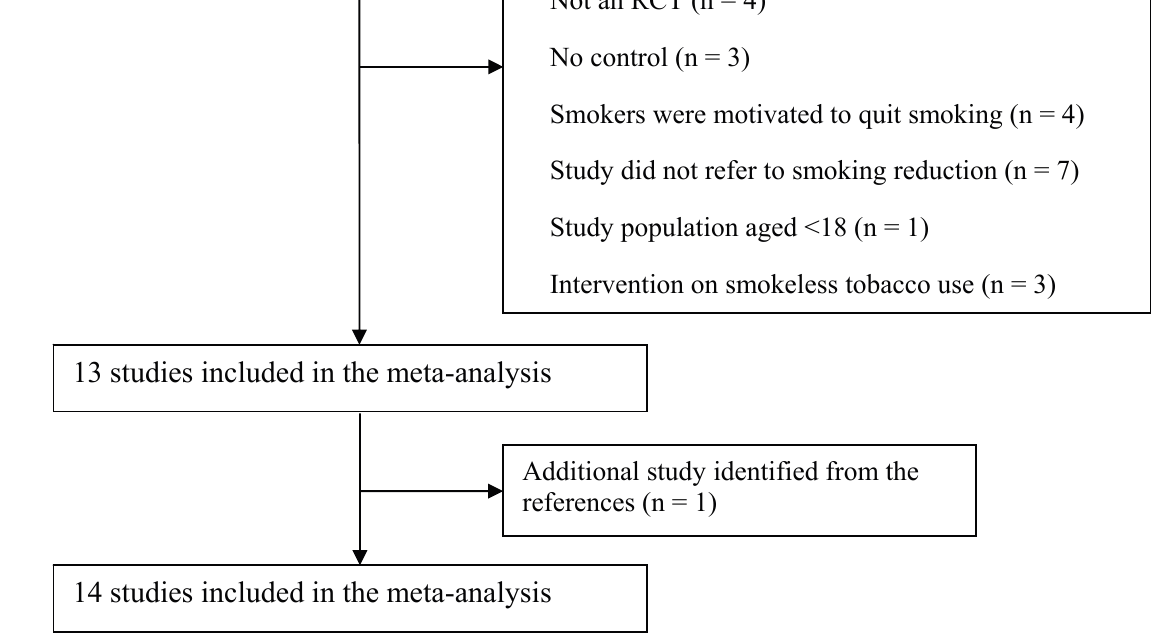
Figure 1. Flow diagram of trials included in the